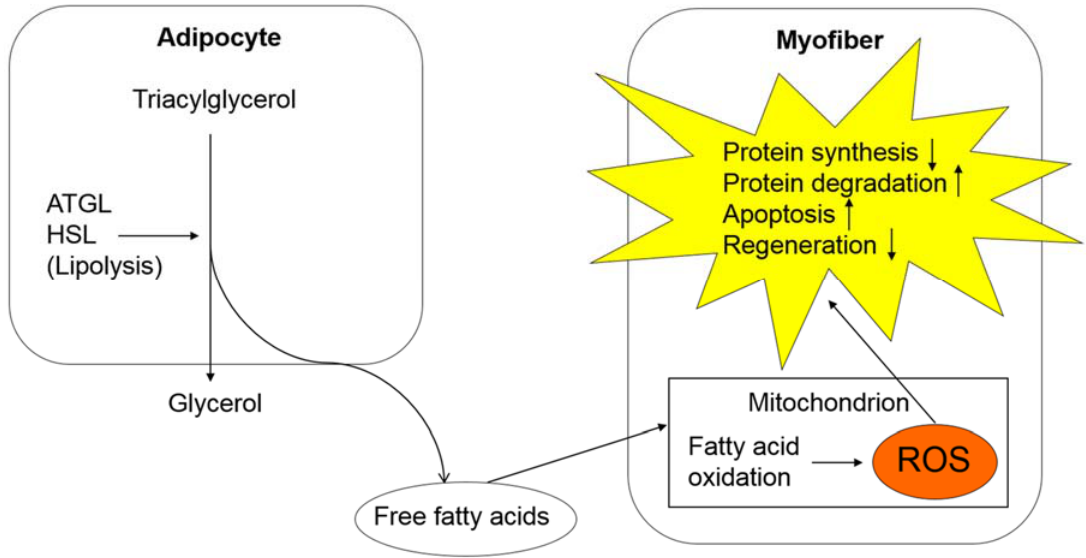
Figure 2. Oxidative stress in cancer cachexia and its effect on skeletal muscle tissues. In adipose tissues, lipolysis is upregulated, which results in increased fatty acid production. A large amount of fatty acids undergo an oxidation process in the mitochondria of myofibers, causing an excessive production of ROS. ROS is involved in various processes, including decreased protein synthesis, increased protein degradation, upregulated apoptosis, and downregulated skeletal muscle regeneration. Abbreviations: Adipose triglyceride lipase, ATGL; hormone-sensitive lipase, HSL; reactive oxygen species, ROS.